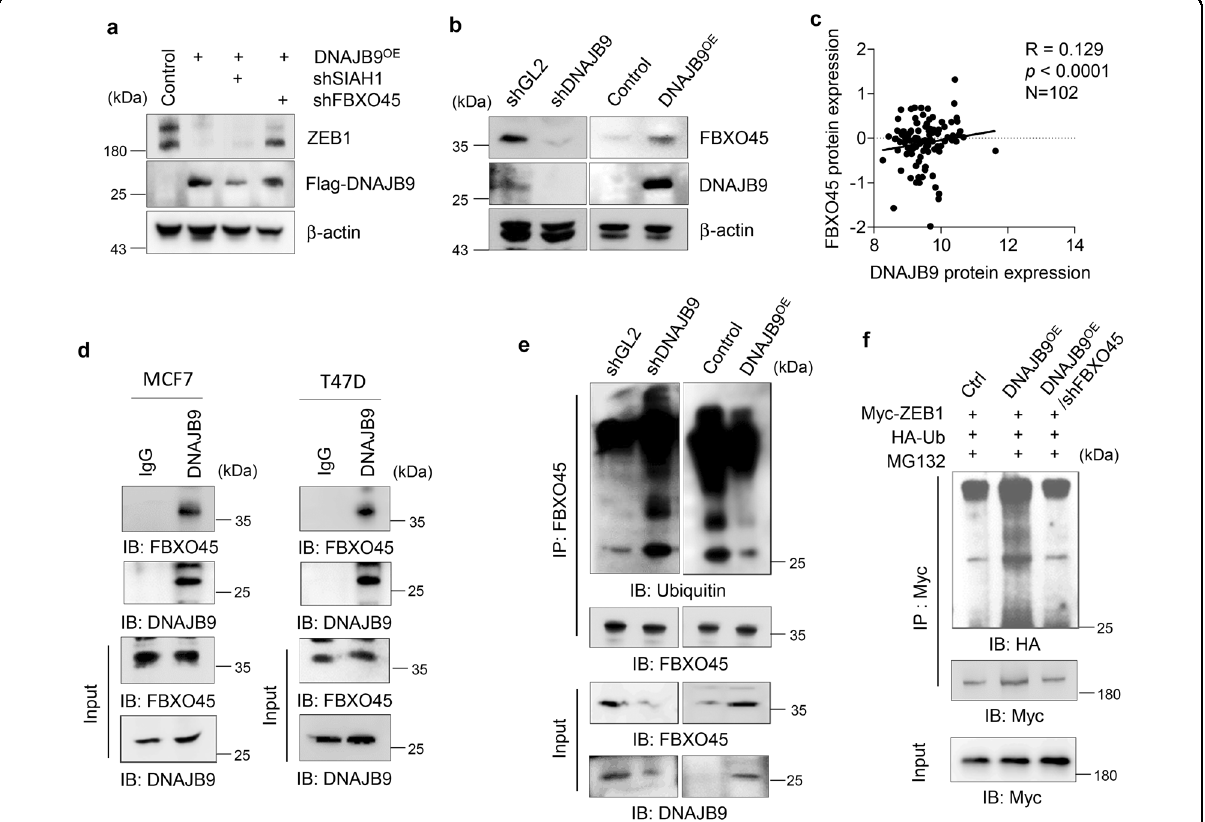
Fig. 4 DNAJB9 regulates ZEB1 through FBXO45-mediated ubiquitination. a To identify the target for ZEB1 degradation, shRNAs against SIAH1 or FBXO45 were introduced into MDA-MB-231 cells. Then the expression level of ZEB1 proteins was checked using western blotting. b The expression levels of FBXO45 proteins were checked using western blotting in MCF7 – shDNAJB9 and MDA-MB-231 – DNAJB9-OE cells. c The Pearson correlation between DNAJB9 and FBXO45 protein expression in 102 breast cancer tissues from The Cancer Genome Atlas database. The Pearson correlation coef fi cient ( R ) and p value ( p ) are reported. d To con fi rm the interaction between DNAJB9 and FBXO45, MCF7 and T47D cell lysates were subjected to immunoprecipitation with control IgG or anti-DNAJB9 antibodies. The immunoprecipitates were detected using the indicated antibodies. e To con fi rm the inhibitory effect of DNAJB9 on FBXO45 ubiquitination, MCF7 – shDNAJB9 and MDA-MB-231 – DNAJB9-OE cell lysates were subjected to immunoprecipitation with an anti-FBXO45 antibody. Then the immunoprecipitated FBXO45 was detected with an anti-ubiquitin antibody. f To validate the FBXO45-mediated ubiquitination of ZEB1, indicated cells were transfected using ZEB1 and ubiquitin constructs. Then the immunoprecipitated ZEB1 was detected with an anti-HA antibody. Results are presented as mean ± standard deviation from three independent